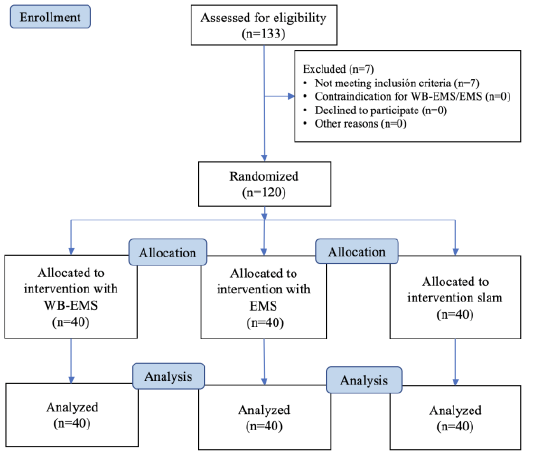
Figure 6. Flow diagram including all phases of the randomized clinical trial [34].